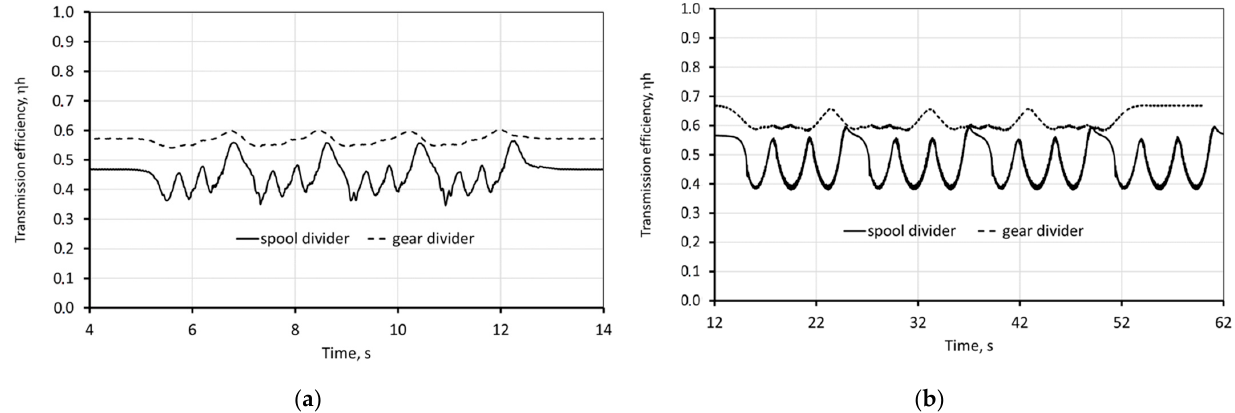
Figure 20. Transmission efficiency with nominal pump flow ( a ) and 25% of nominal pump flow ( b ) for spool and gear flow dividers.